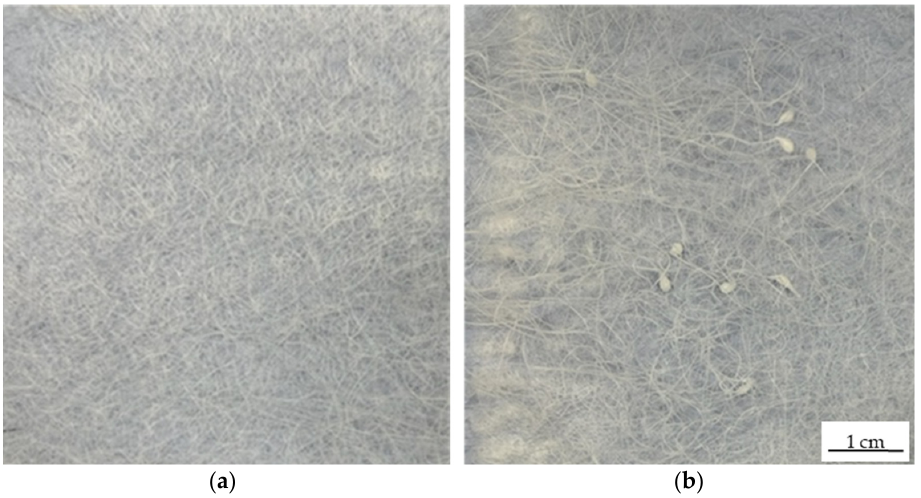
Figure 8. Fiber web samples produced using the pilot-scale melt-electrospinning equipment at a pump speed of 5 rpm and a nozzle-to-collector distance of 10 cm. ( a ) Negatively charged ( − 30 kV) collector. ( b ) Positively charged (+30 kV) collector.